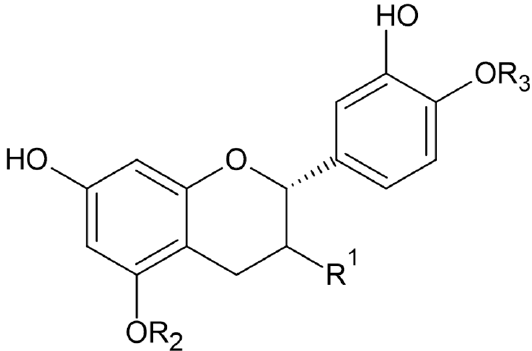
Figure 8. Catechin and epicatechin. Figure 9. Apigenin and derivatives. Table 4 . Catechin and epicatechin. Table 5 . Apigenin and derivatives.